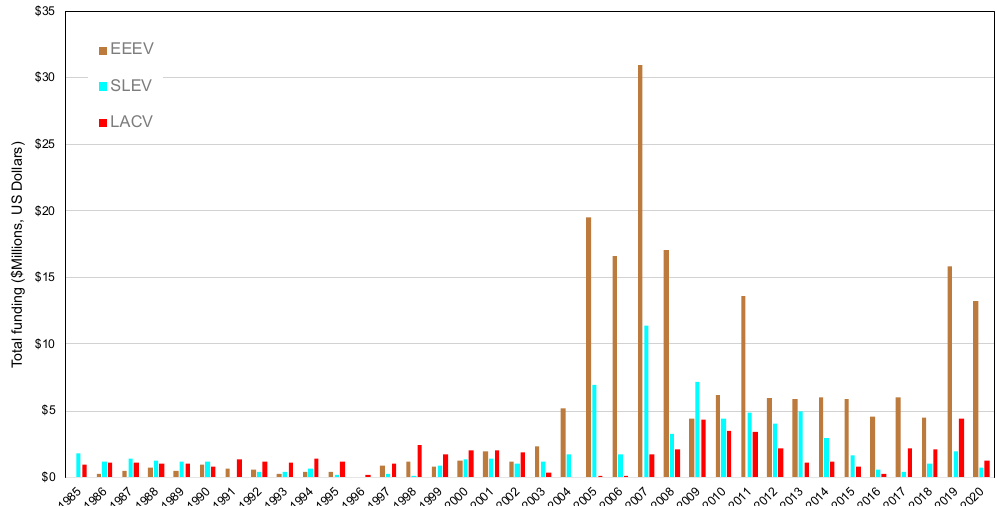
Figure 2. Total funding by the National Institutes of Health based on the NIH Reporter search query of projects matching Eastern equine encephalitis virus (EEEV), St Louis encephalitis virus (SLEV), and